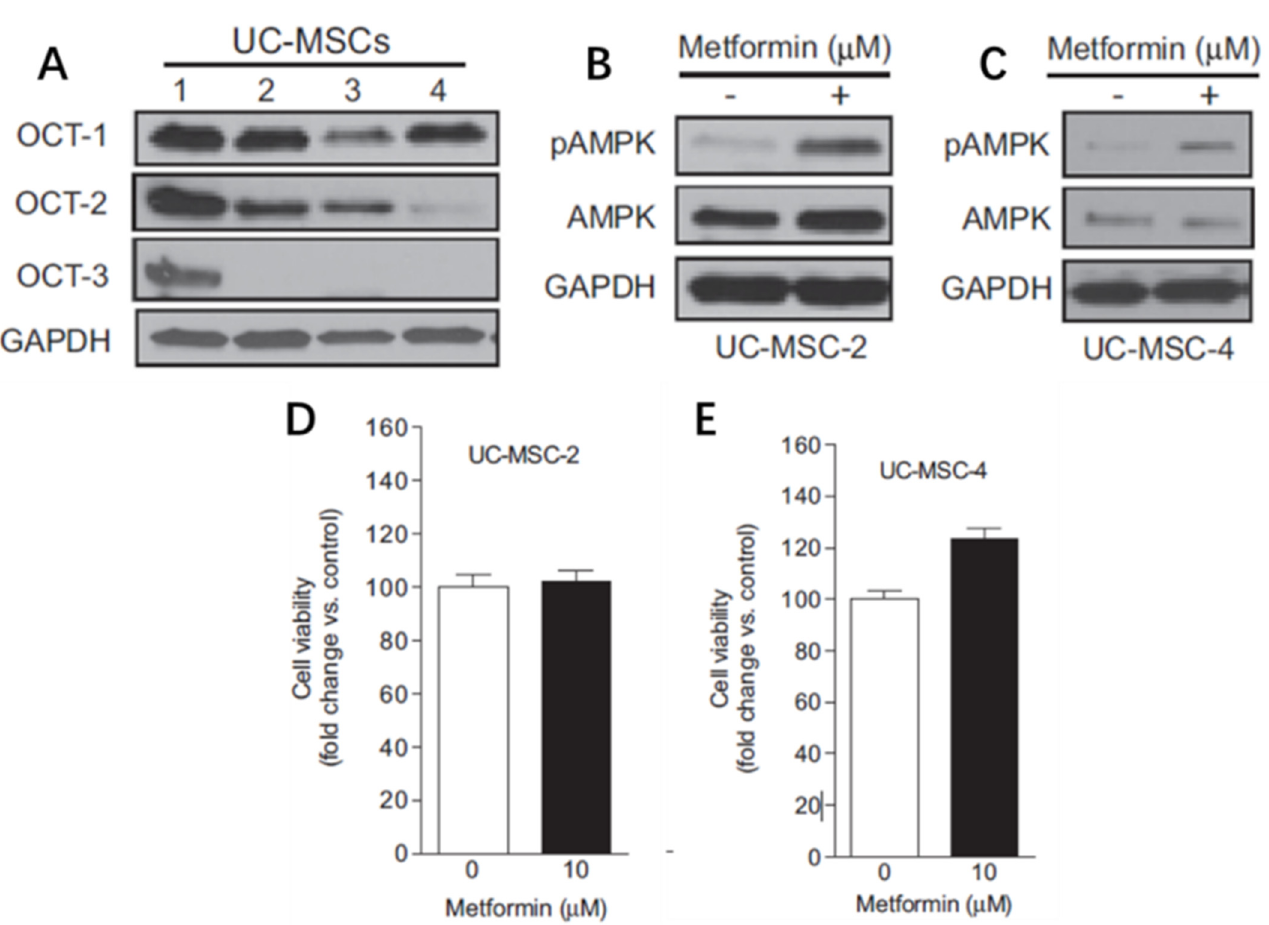
Figure 7. UC-MSCs expressing OCT to ingest metformin. ( A – C ) Organic cation transporter (OCT) protein levels in umbilical cord mesenchymal stomal cells (UC-MSCs). ( D , E ) Transfection of OCT1 small interfering RNA (siRNA) duplex to downregulate metformin accumulation and RUNX family transcription factor 2 (Runx2) expression in UC-MSCs. AMPK, AMP-activated kinase; pAMPK, phosphorylated AMPK; GAPDH, glyceraldehyde-3-phosphate dehydrogenase (Adapted from reference [31], with permission).